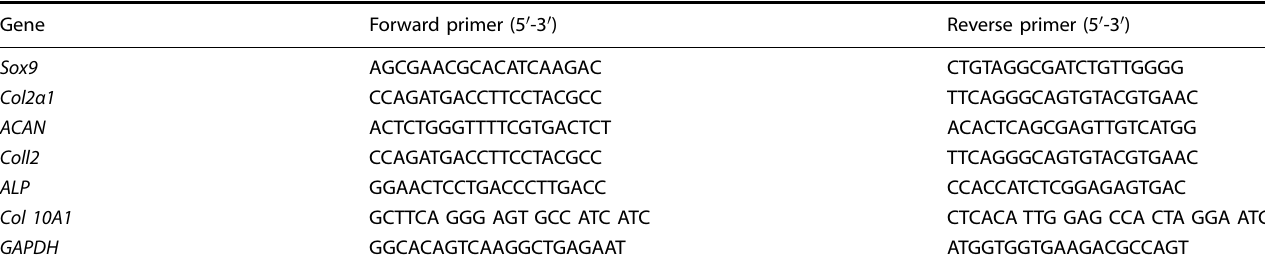
Table 3. Primer sequences for RT-PCR analysis.